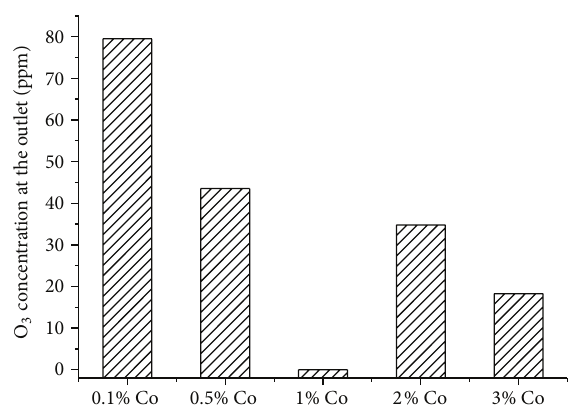
Figure 7: Effect of Co loading amount on ozone concentration at the